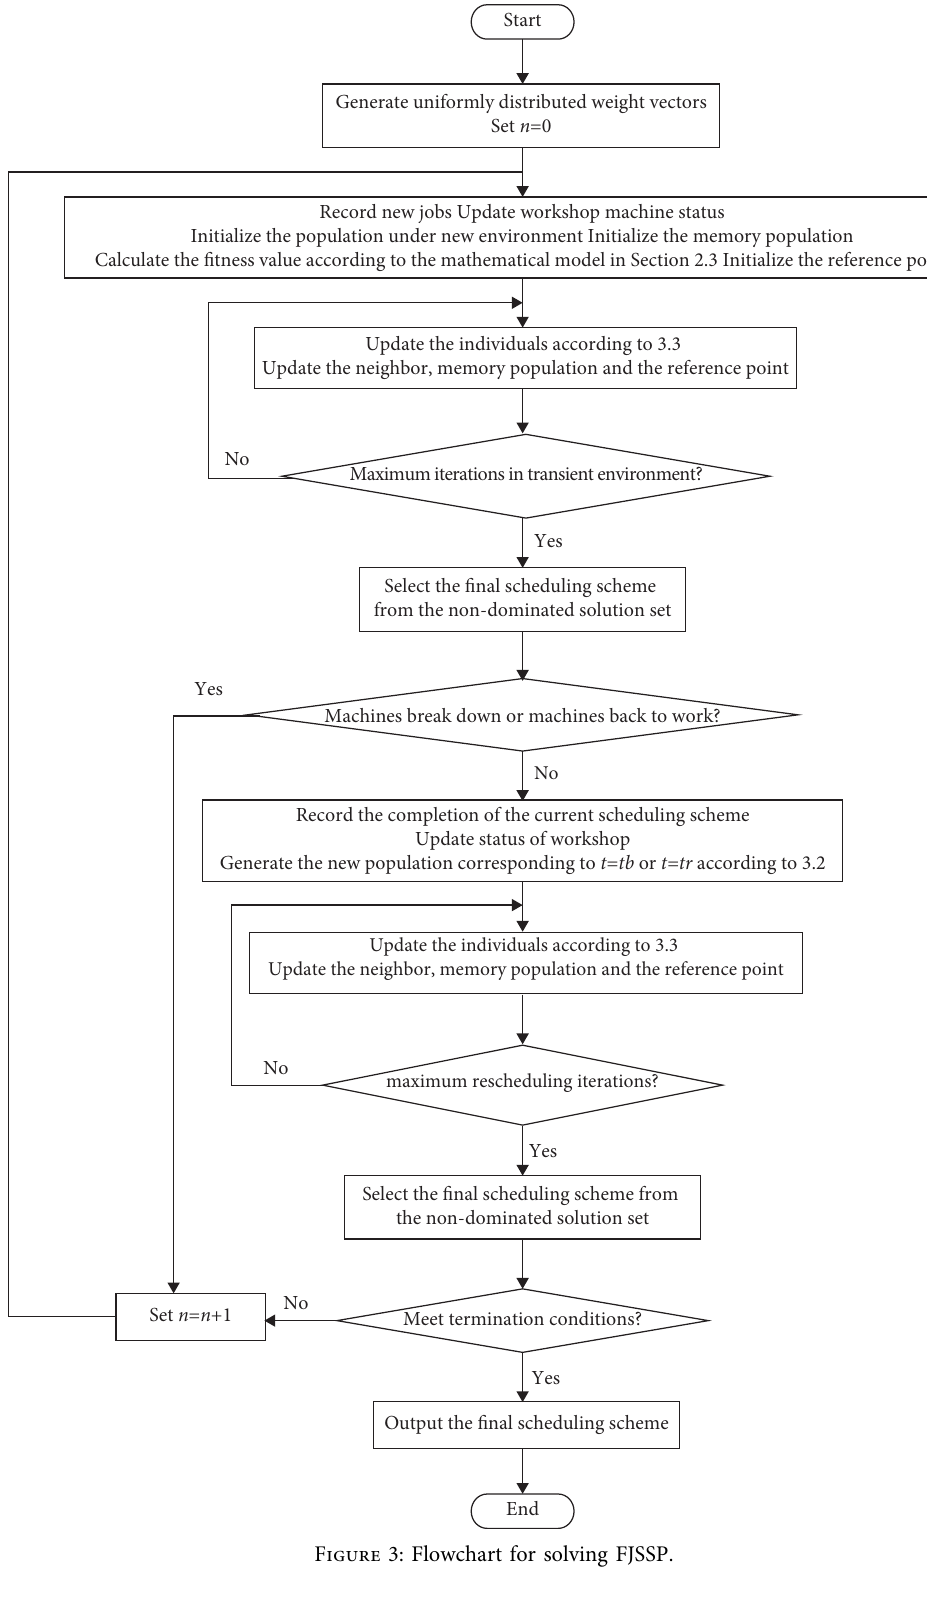
Figure 3: Flowchart for solving